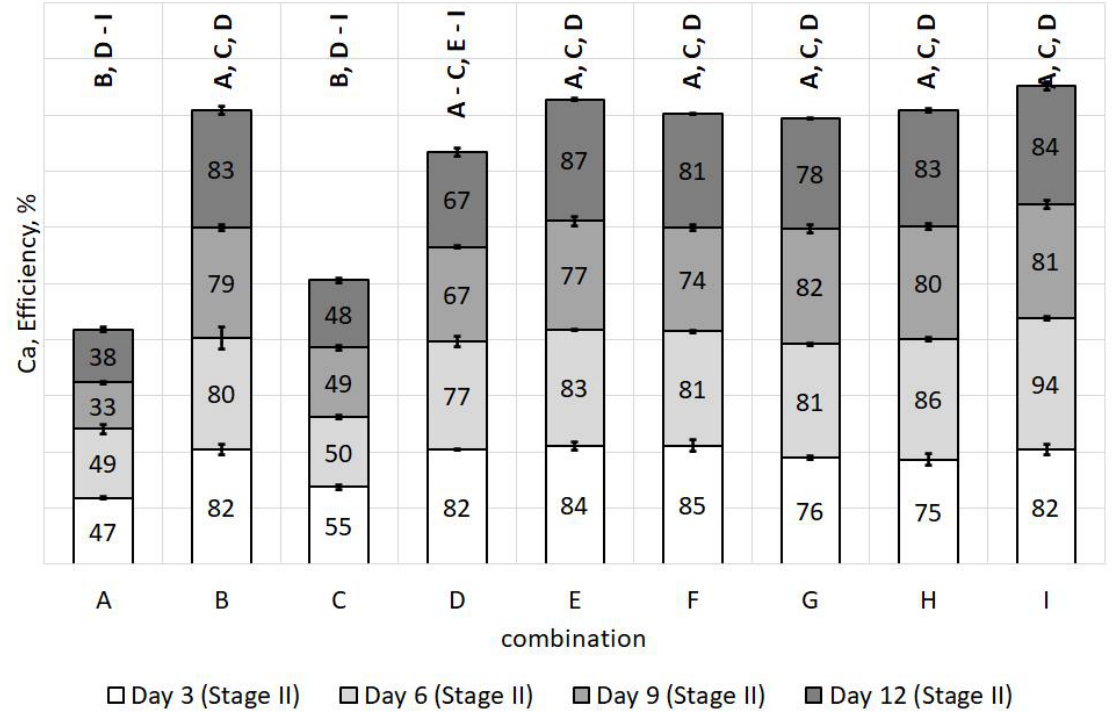
Figure 8. Effectiveness of Ca release to the dissolved fraction of leachate (Stage II).